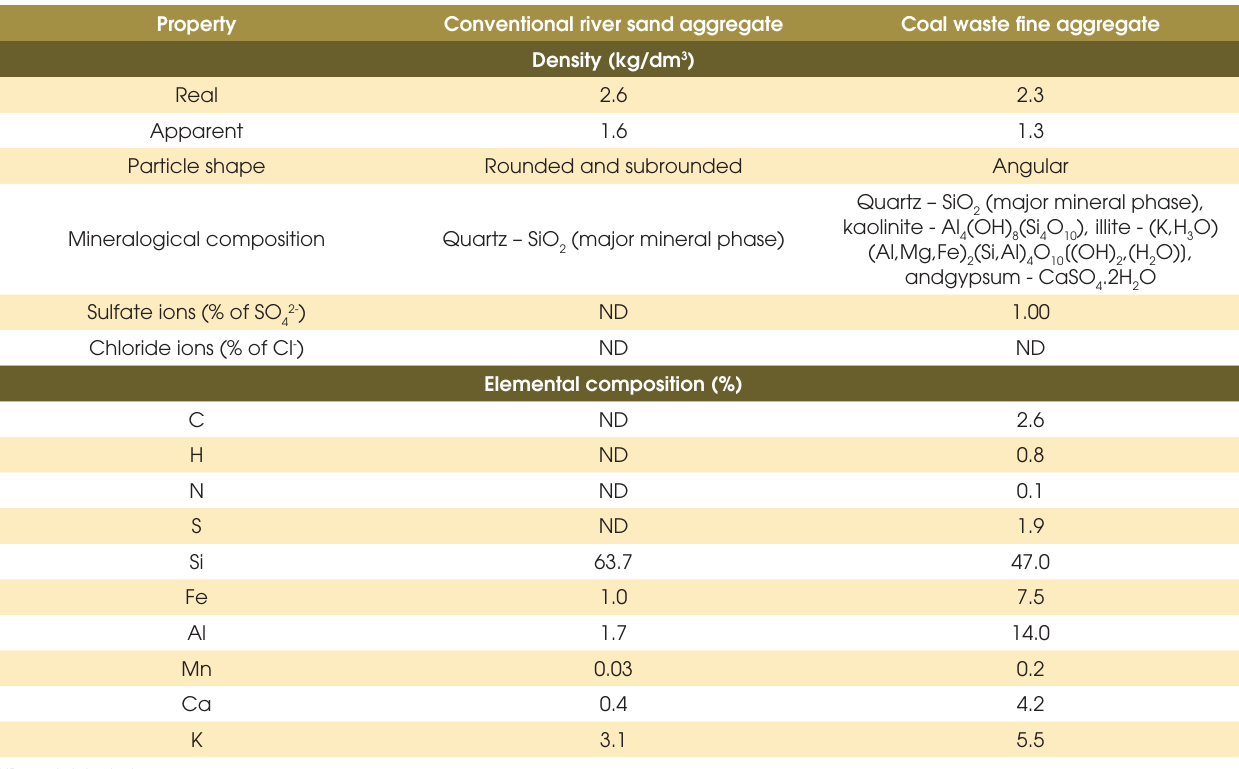
Table 1 – Properties of conventional quartz sand aggregates and the coal waste fine aggregate Property